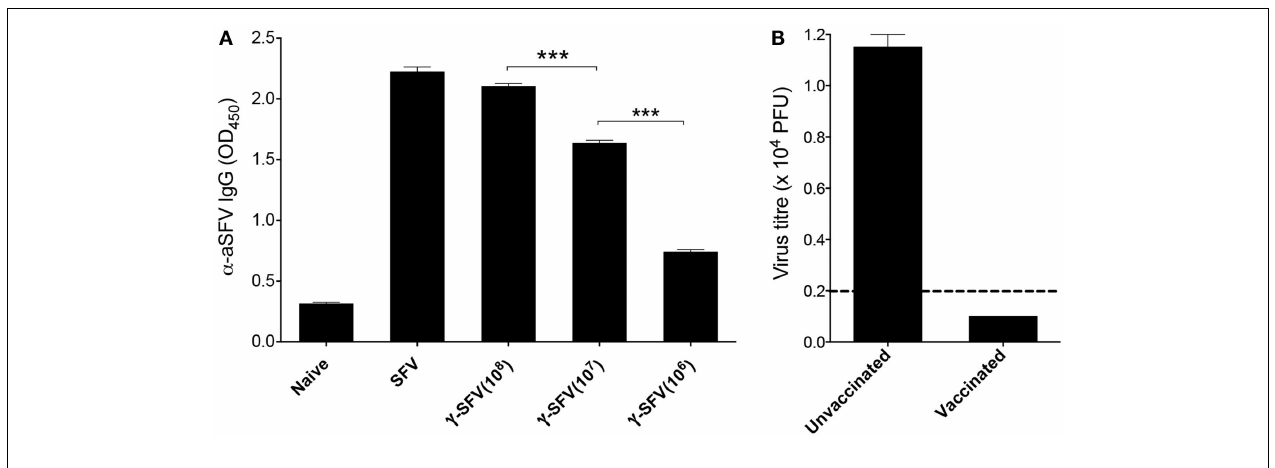
equivalent/mouse) and challenged 14days post-vaccination with SFV (10 7 PFU).Twenty four hours post-challenge, serum SFV titers were determined by plaque assay. Un-vaccinated naive mice infected with SFV served as control. Results are presented as mean ± SEM ( n = 3) and dashed line represents our assay detection limit of 100 PFU, *** p <